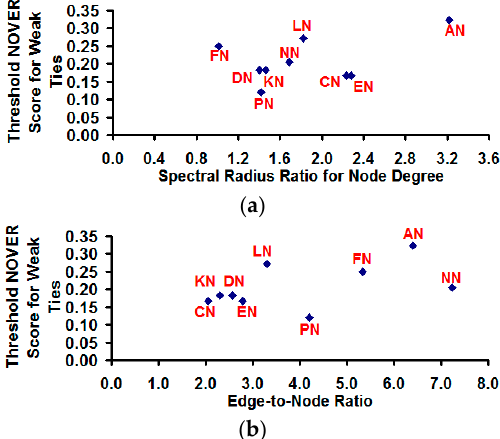
Figure 15. Dependence of the threshold NOVER score for weak ties on the spectral radius ratio for node degree and the edge-to-node ratio. ( a ) Spectral radius ratio for node degree vs. Threshold NOVER score for weak ties; ( b ) Edge-to-node ratio vs. Threshold NOVER score for weak ties.